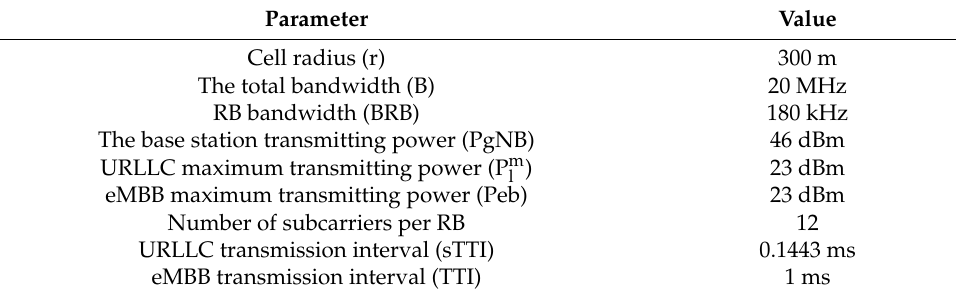
Table 1. Parameter